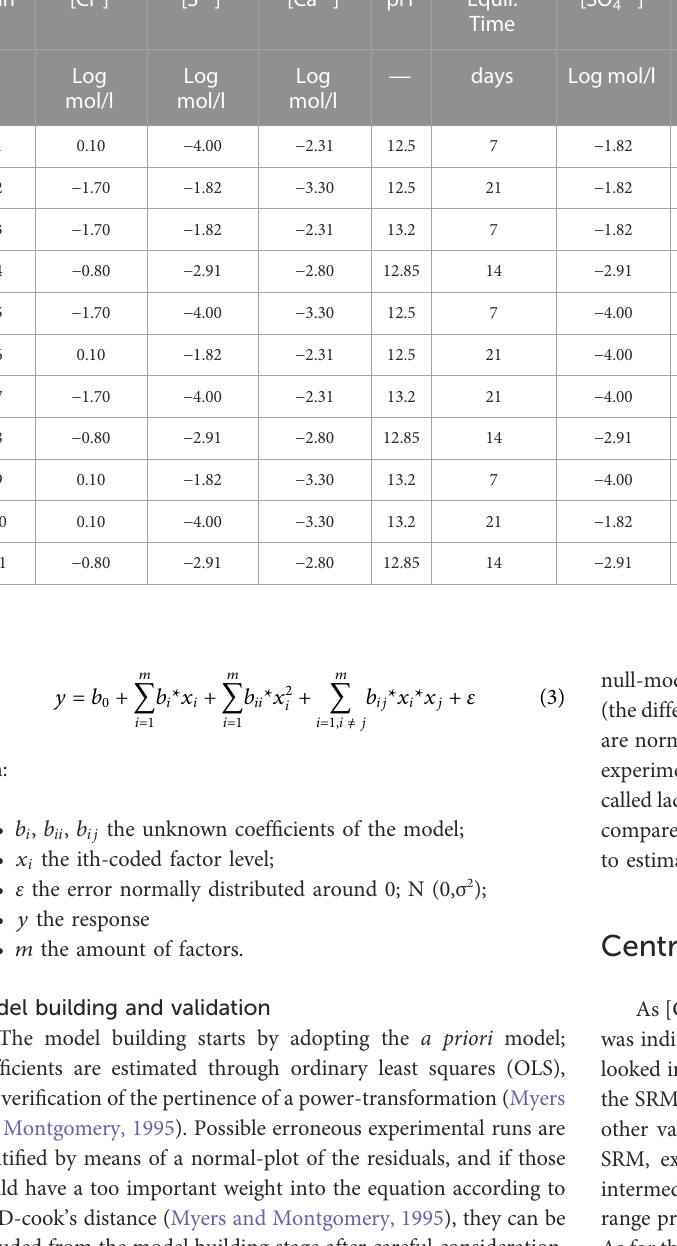
TABLE3Experimentalplanfor thescreeningdesign. Allfactors, except forpH andtheequilibrium time,werelog-transformed. [Pu],S/Land[K]weregroupedand as such varied simultaneously. [ISA] was kept constant in the screening. [Na + ] was considered as fl oating to allow balancing of the solutions.